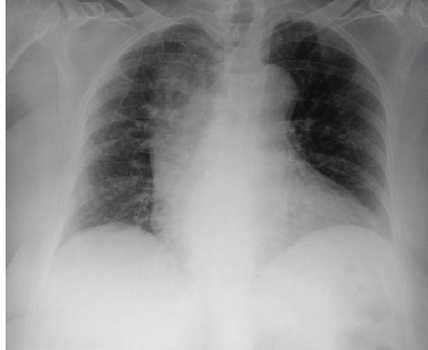
Figure 2: Chest X-ray on admission: right upper lobe alveolar